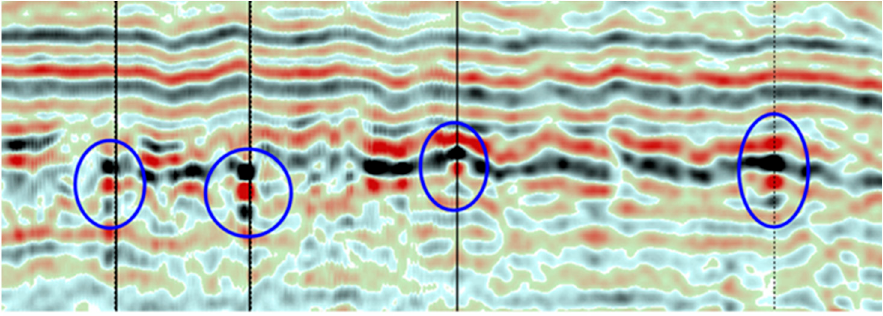
Figure 1. Beaded reflection.